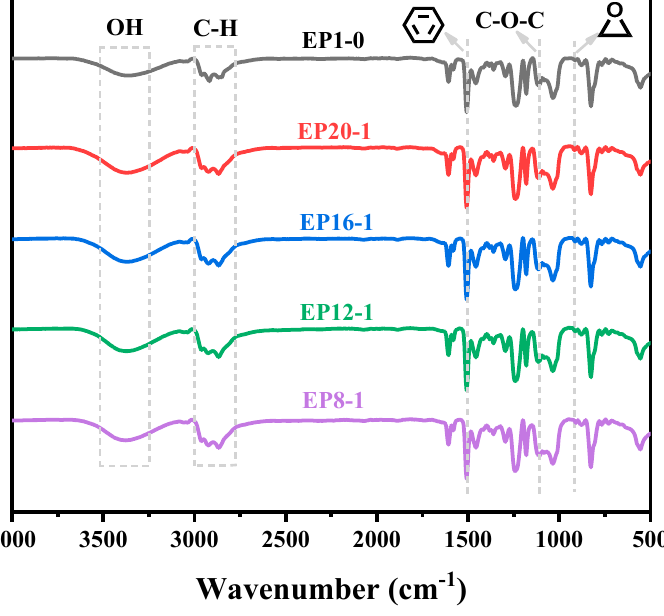
Figure 5. FT-IR spectra of EPx samples.